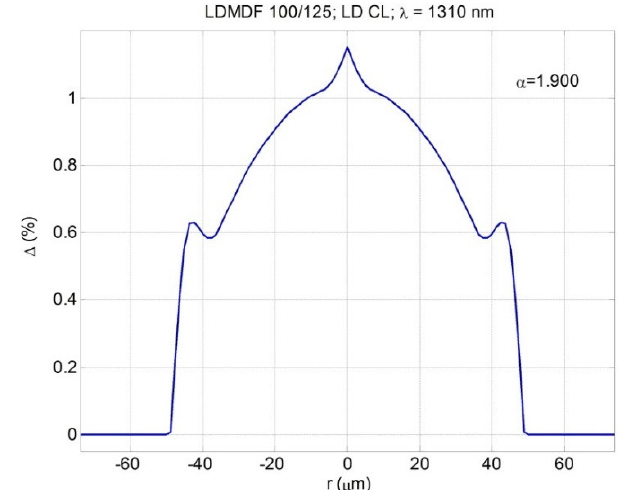
Figure 5. Optimized graded refractive index profile for a 100 µ m core low differential mode delay fiber (LDMDF).